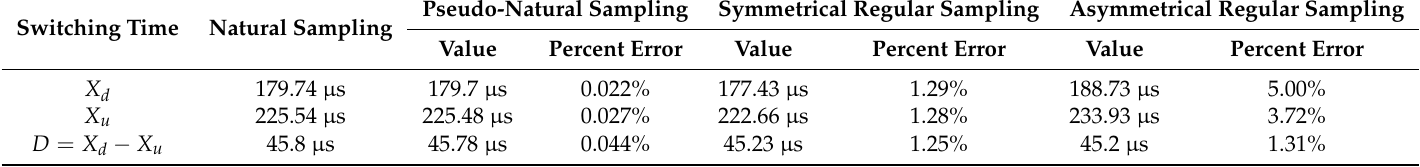
Table 1. Comparison of sampling methods when the modulator is within the angle 0 < θ < 2 π / M f . A = 0.9 Switching instants are obtained from MATLAB and Pspice